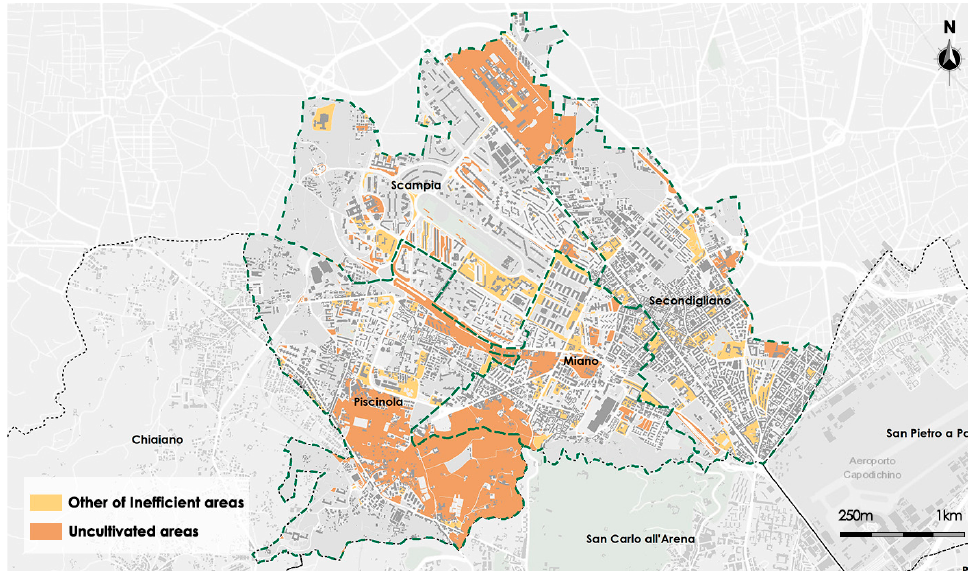
Figure 6. Spatial distribution of uncultivated and other ecologically inefficient green surfaces. Table 5. Statistics of districts by ecological efficiency after planting works.